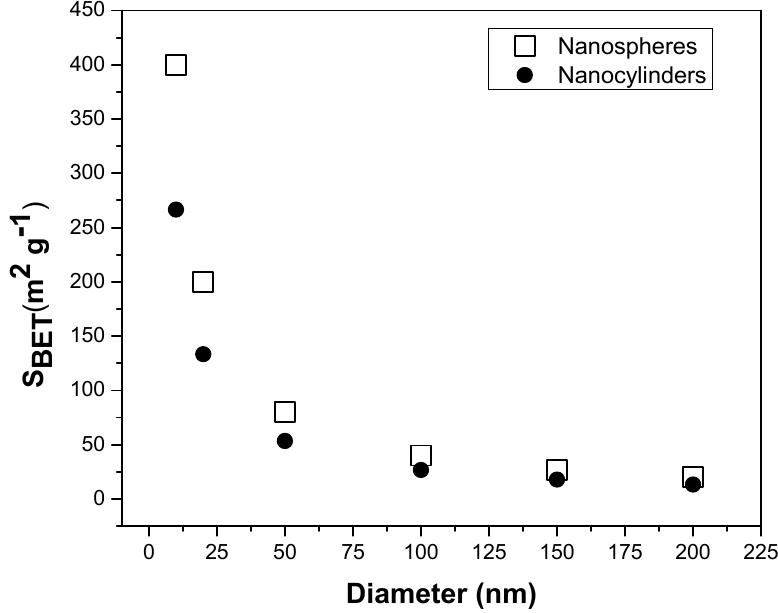
Figure 2. Calculated S BET of PANI nano-objects as a function of the diameter of the object. Another parameter of interest is the time required for a mobile species (counterion, analyte, adsorbate) to reach the center of the nano-object. This parameter is related with the response time of batteries and supercapacitors (where redox pseudocapacitance has a major contribution), response time of sensors and loading time of adsorption nanomateri- als.